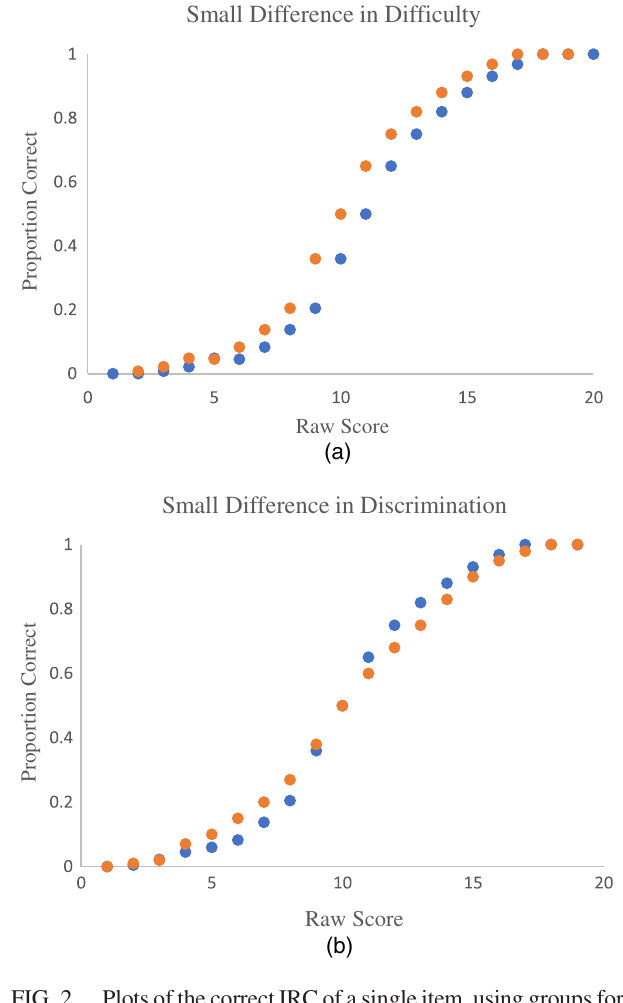
FIG. 2. Plots of the correct IRC of a single item, using groups for which the item has a different (a) difficulty and (b) discrimination. Red dots and blue dots represent the groups in